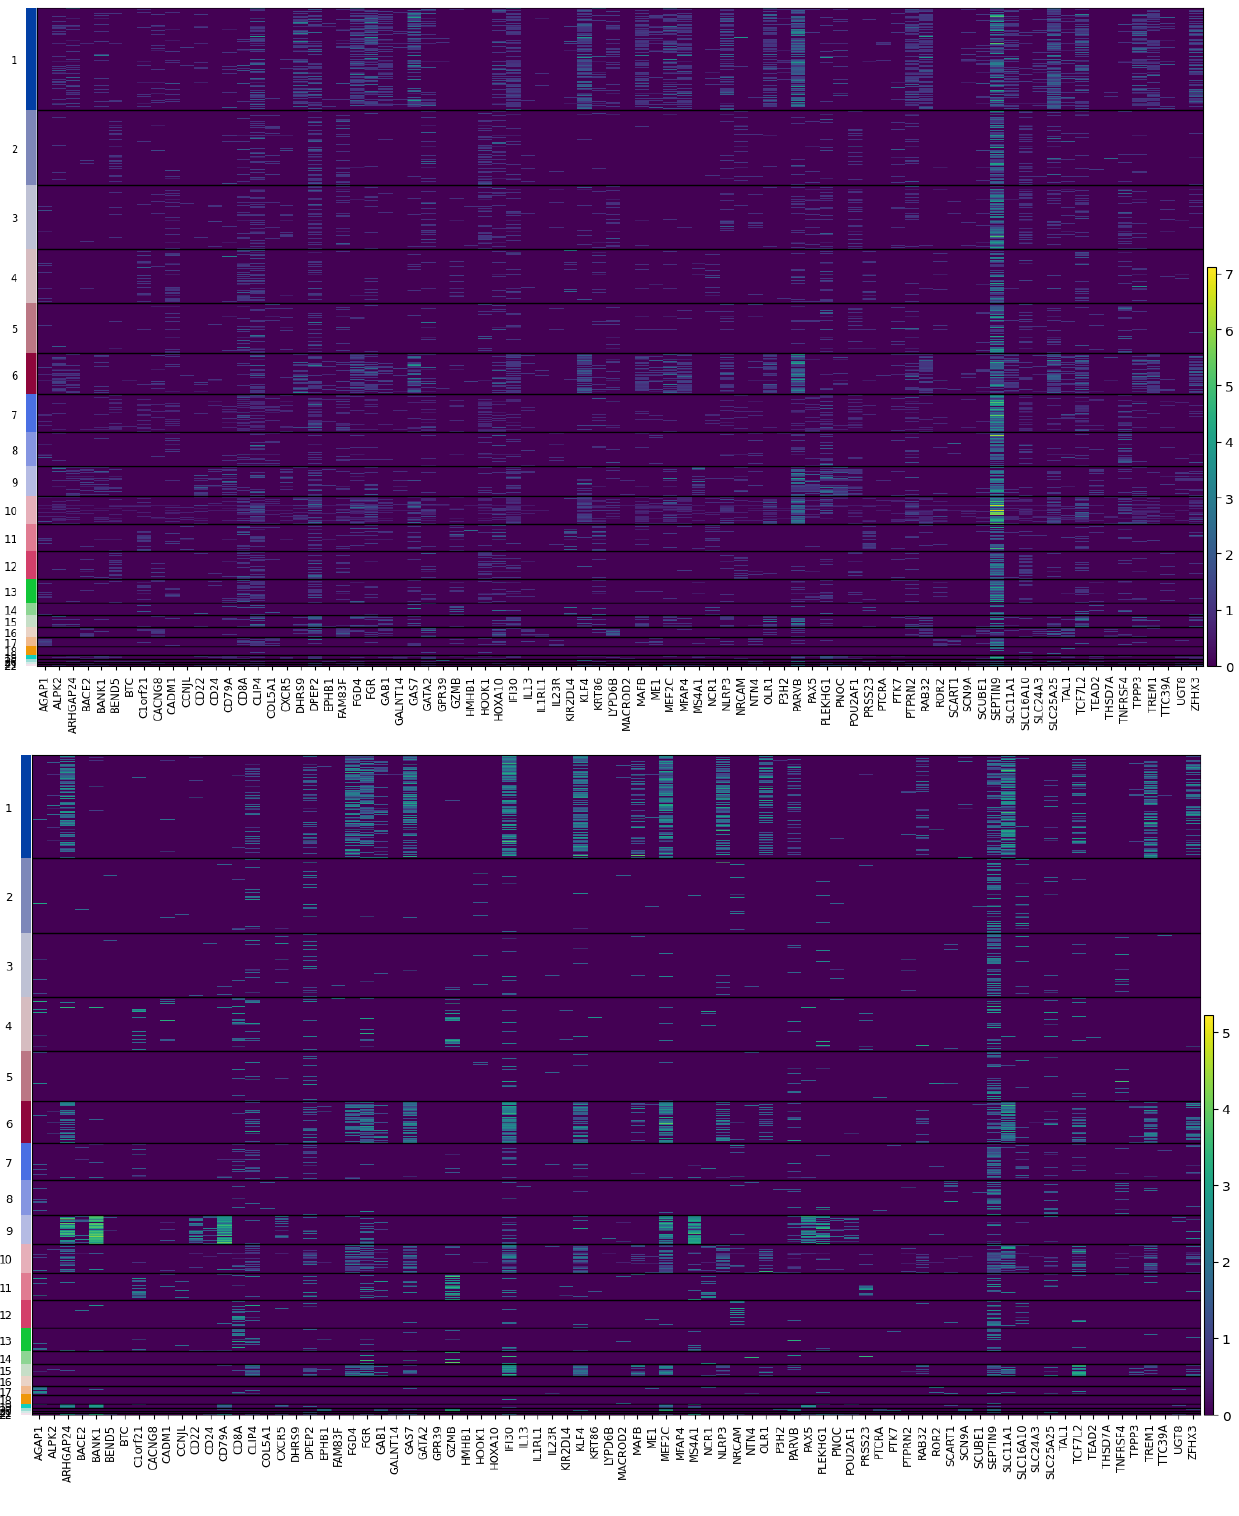
Figure 11. Heatmap for the top 10 DA genes, showing their Activity (on the top ) and Expression (on the bottom ) profiles throughout the whole 10X Multiome Controller PBMC dataset. Again, one can notice repeated patterns between the